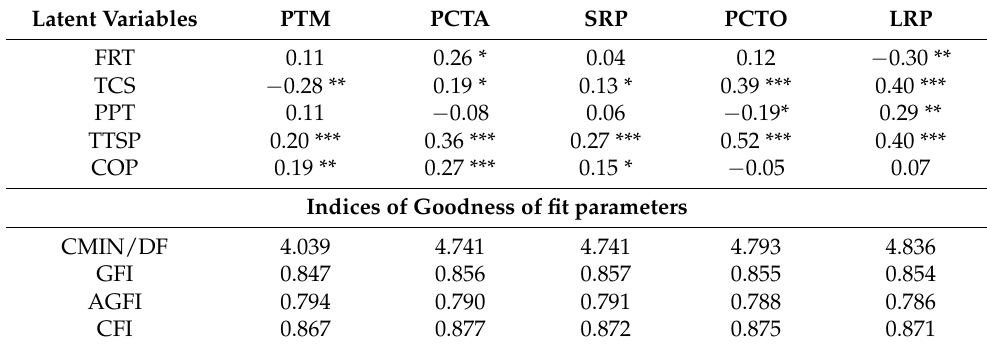
Table 5. Standardized estimates of regression equations. Latent Variables